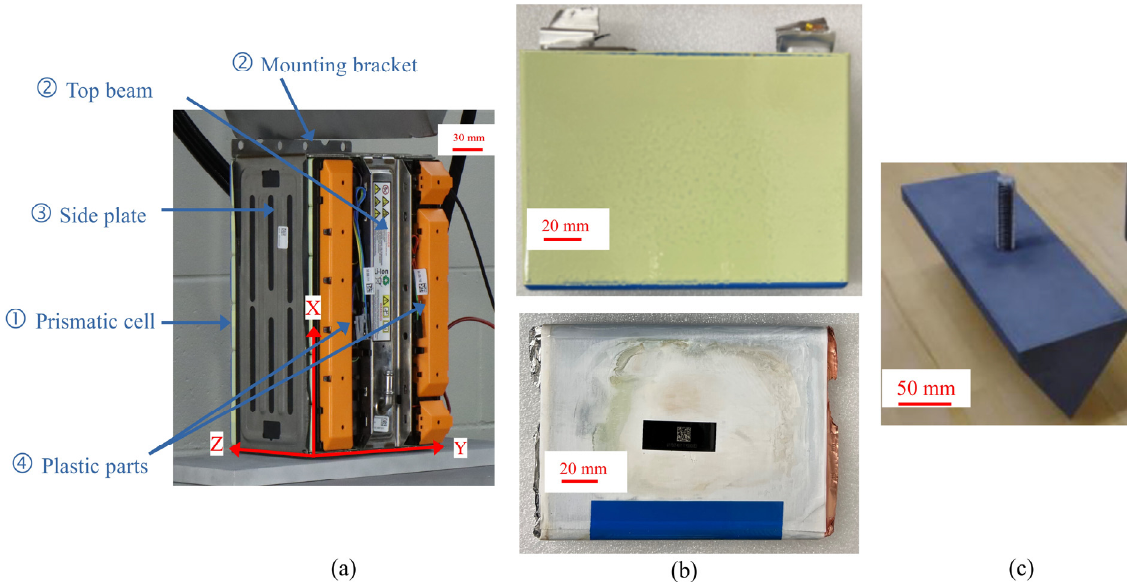
Figure 1. ( a ) Li-ion battery module details with directions marked; ( b ) Typical prismatic cell (top) and jellyroll (bottom); and ( c ) V-shaped stainless-steel wedge used for